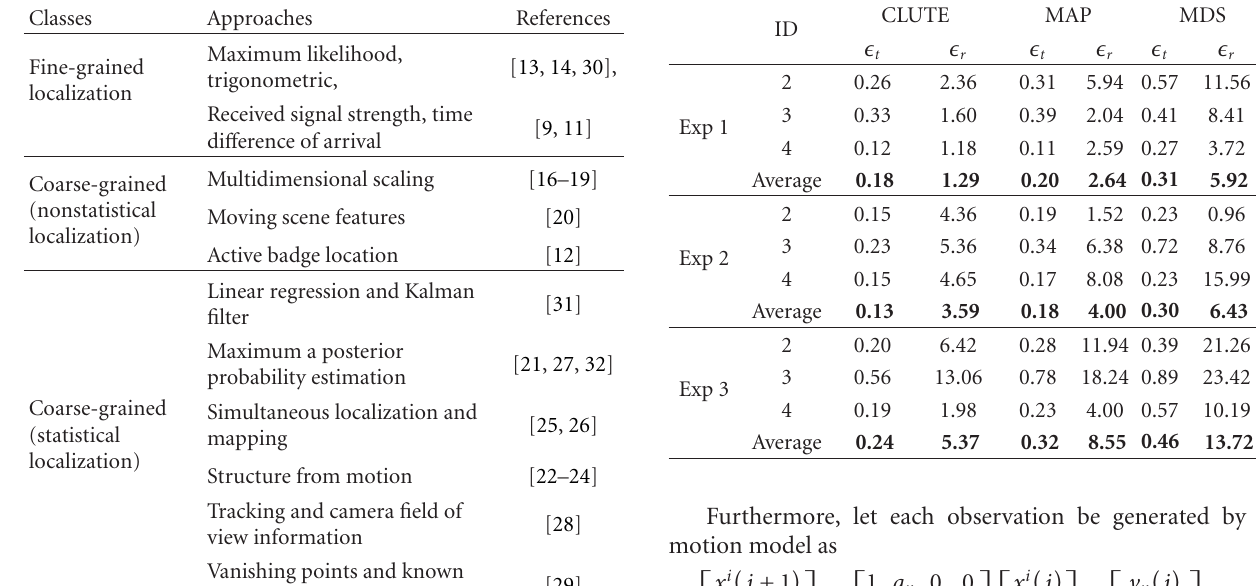
Table 1: Summary of the state-of-the-art approaches for sensor localization.